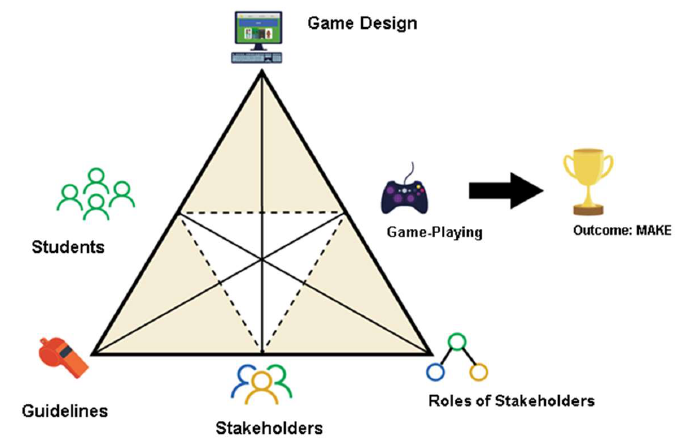
Figure 1. The expanded game activity system framework suggested by Engeström [50].